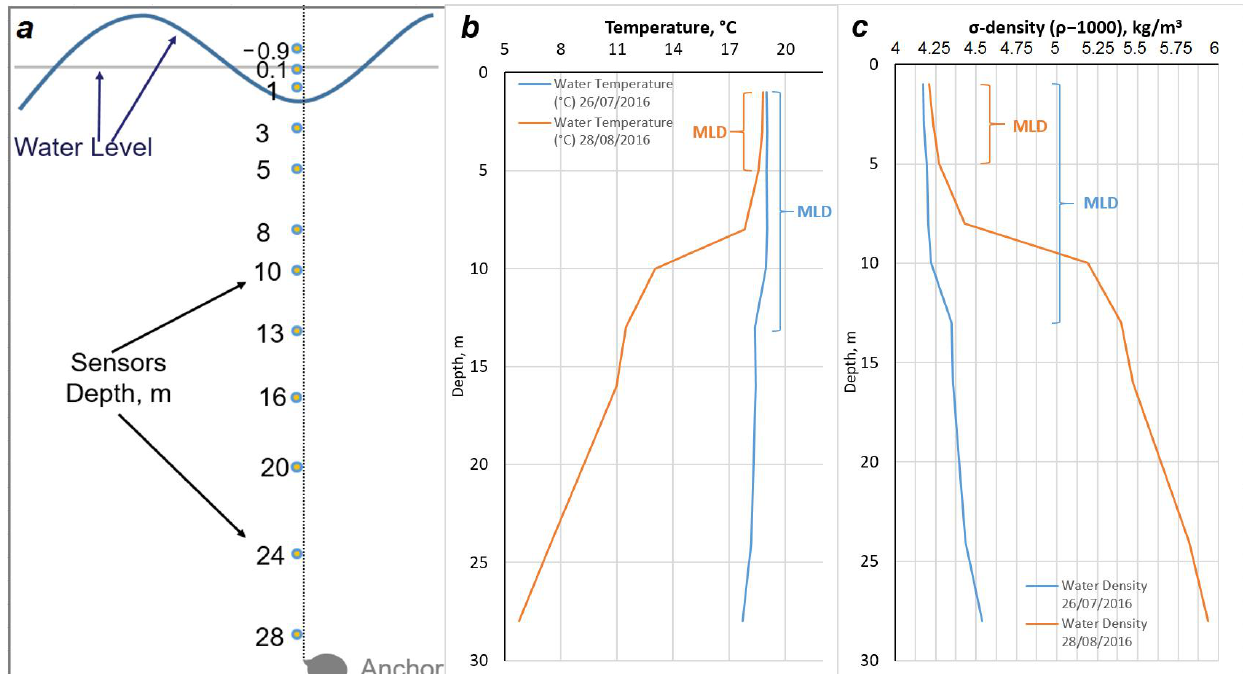
Figure 2. The placement of the temperature sensors on the thermistor chain ( a ). Example of vertical temperature profiles and corresponding MLD ( b ), vertical density profiles ( c ) with x-axis spacing of 0.125 kg/m 3 .